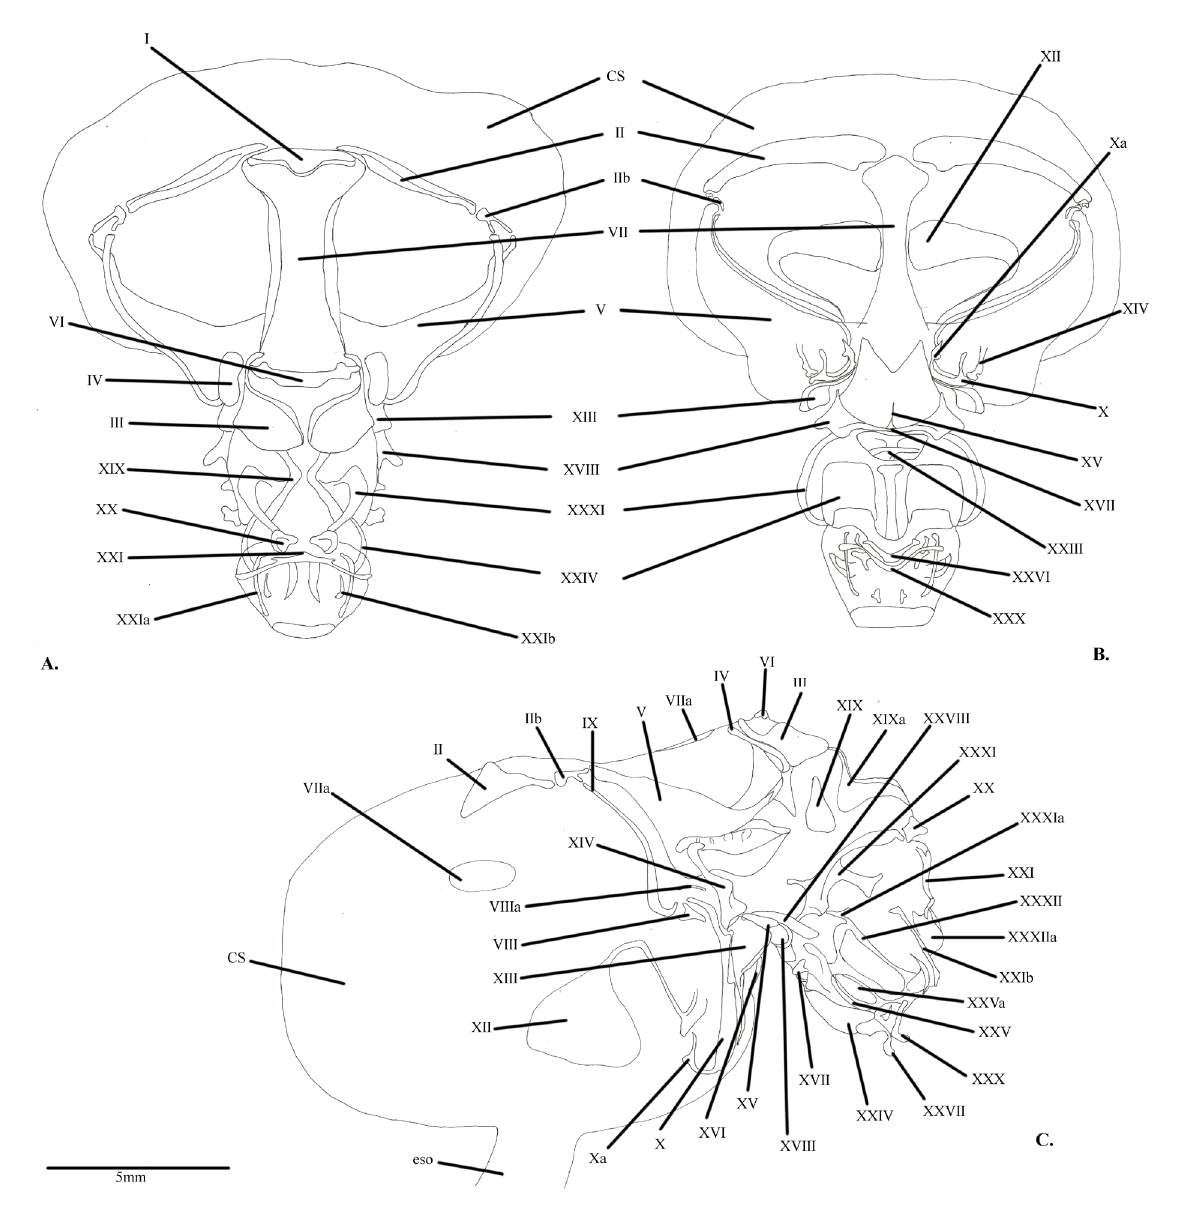
Figure 4. Moreirocarcinus laevifrons (Moreira, 1901), cardiac and pyloric chambers of the foregut. A, Dorsal view; B, ventral view; C, lateral view. Abbreviations: CS, cardiac sac; eso, esophagus; see Tab. 2 for the nomenclature of the